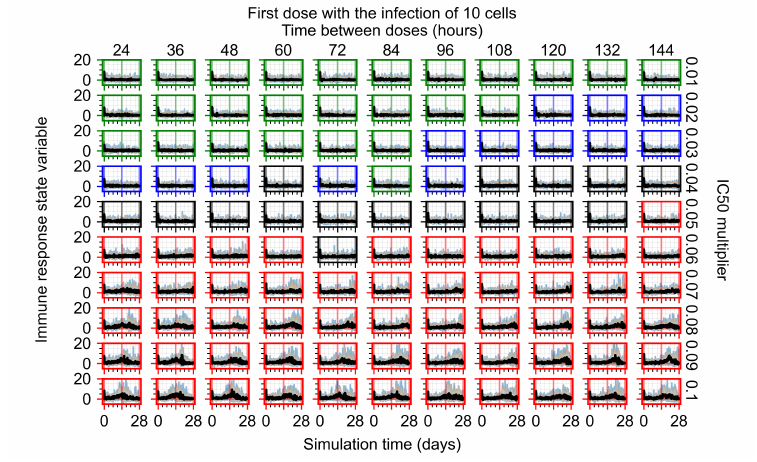
Figure A83. Immune response state variable number. Positive values correspond to an inflammatory state, and negative to an anti-inflammatory state.